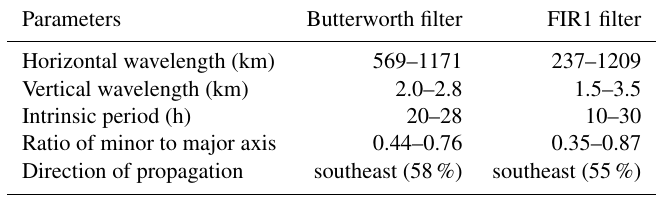
Table 1. Comparison of IGW parameters using detrended time series fluctuations and obtained with different filters.